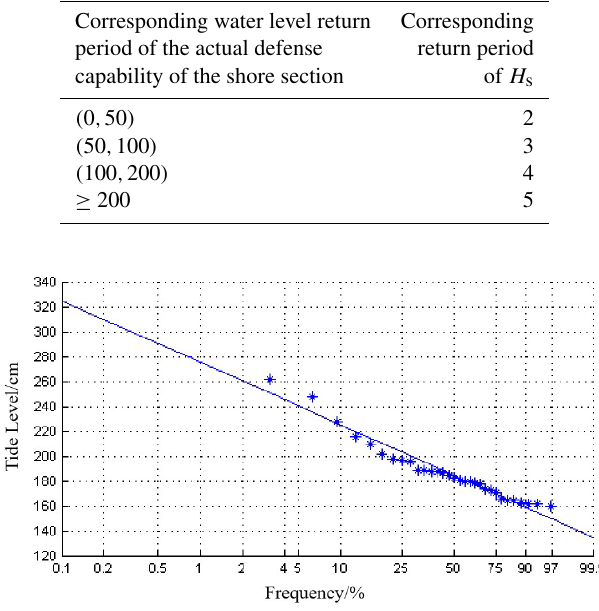
Figure 2. Frequency distribution of the annual maximum value of the high water level at Zhifudao tide gauge